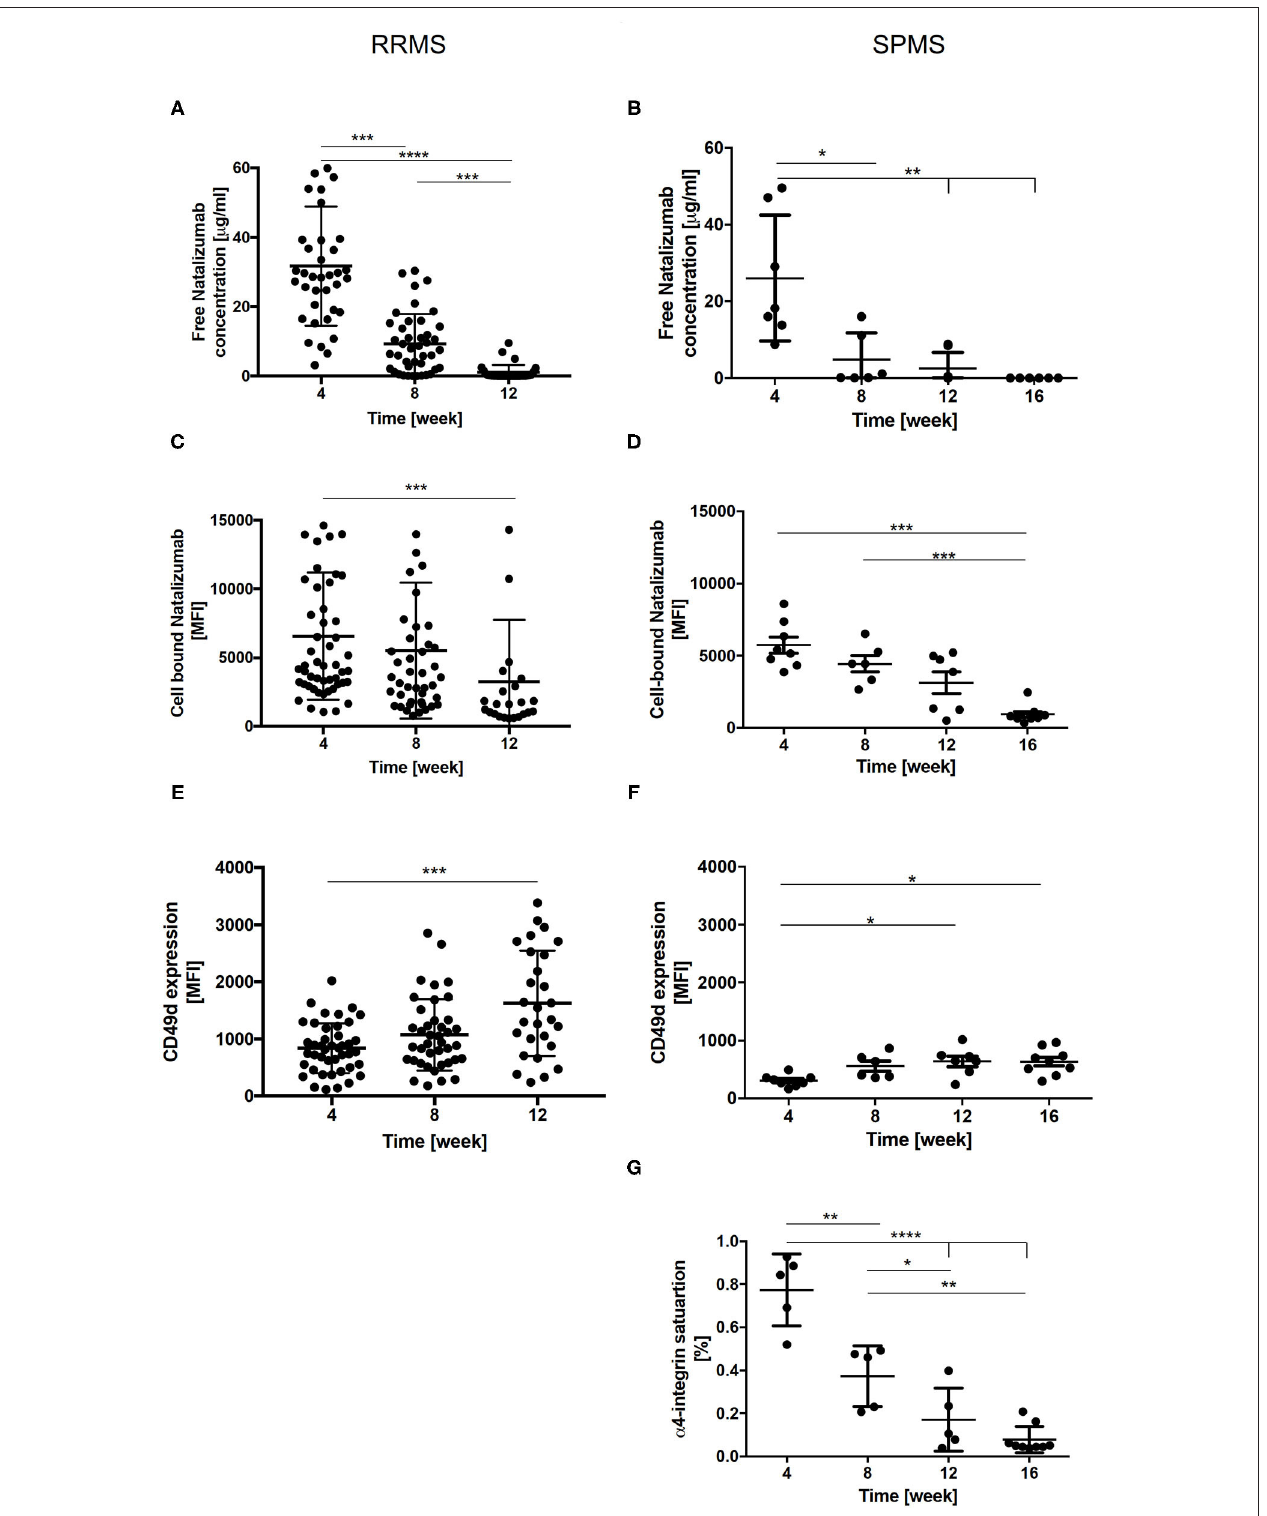
FIGURE 3 | Free NAT concentration, cell bound NAT, CD49d expression and α 4-integrin saturation in RRMS ( n = 50) and SPMS ( n = 9) patients after the cessation of NAT therapy. Mean values ± SD of free NAT concentration in plasma (A,B) , cell bound NAT on CD3 + T-cells (C,D) and CD49d expression on CD3 + T-cells (E,F) were assessed during the washout of NAT up to 12 weeks in RRMS (left) and up to 16 weeks in SPMS (right) patients. For SPMS patients the mean α 4-integrin saturation level on CD3 + T-cells after the cessation of NAT treatment is presented (G) . Data were analyzed by generalized linear mixed models for repeated measures. Asterisks indicate a statistically significant difference (* p < 0.05, ** p < 0.01, *** p < 0.001, **** p < 0.0001). MFI, mean fluorescence intensity.